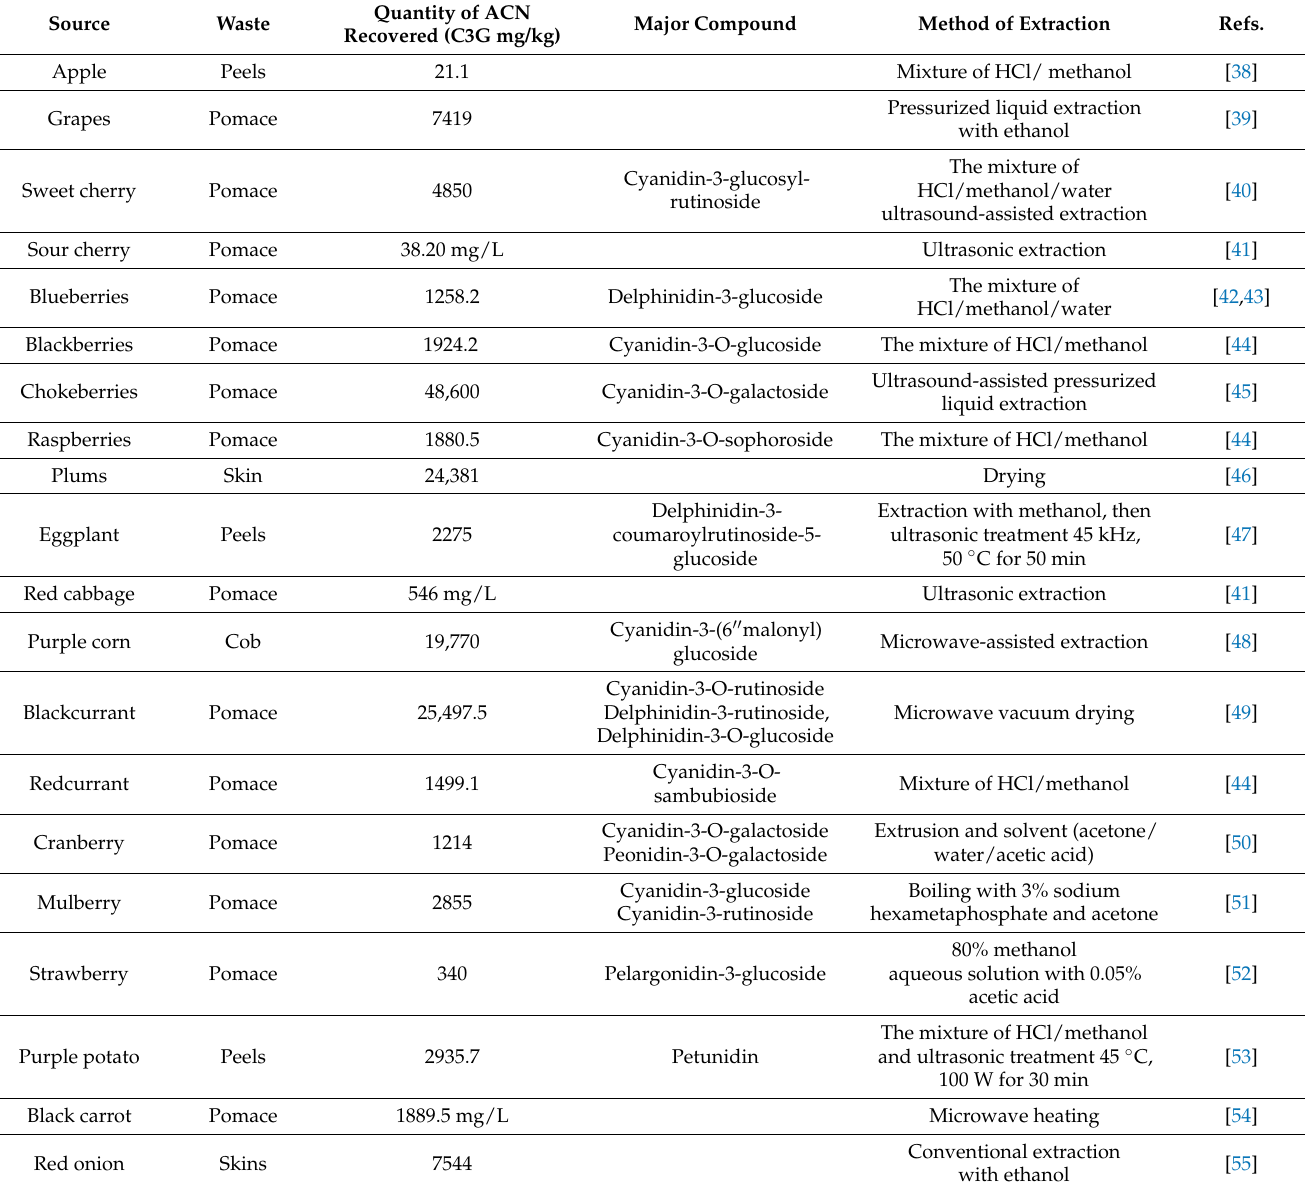
Table 1. Waste rich in anthocyanins, their quantification, major compounds determined, and method of extraction